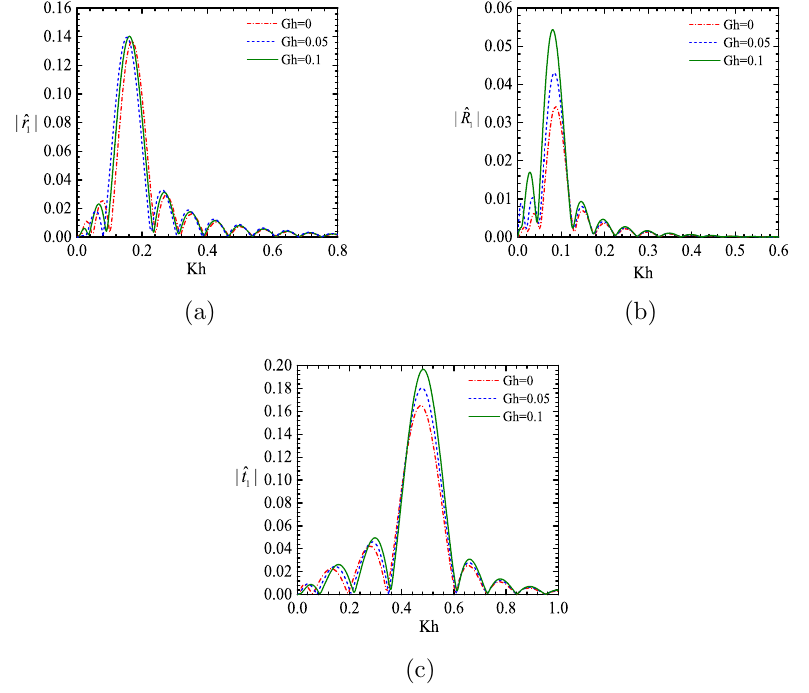
(cid:12) (cid:12) (cid:12) (cid:12) (cid:12) (cid:12) (cid:12)(cid:98) t 1 (cid:12) for (cid:12) (cid:98) R 1 (cid:12) ; (c)